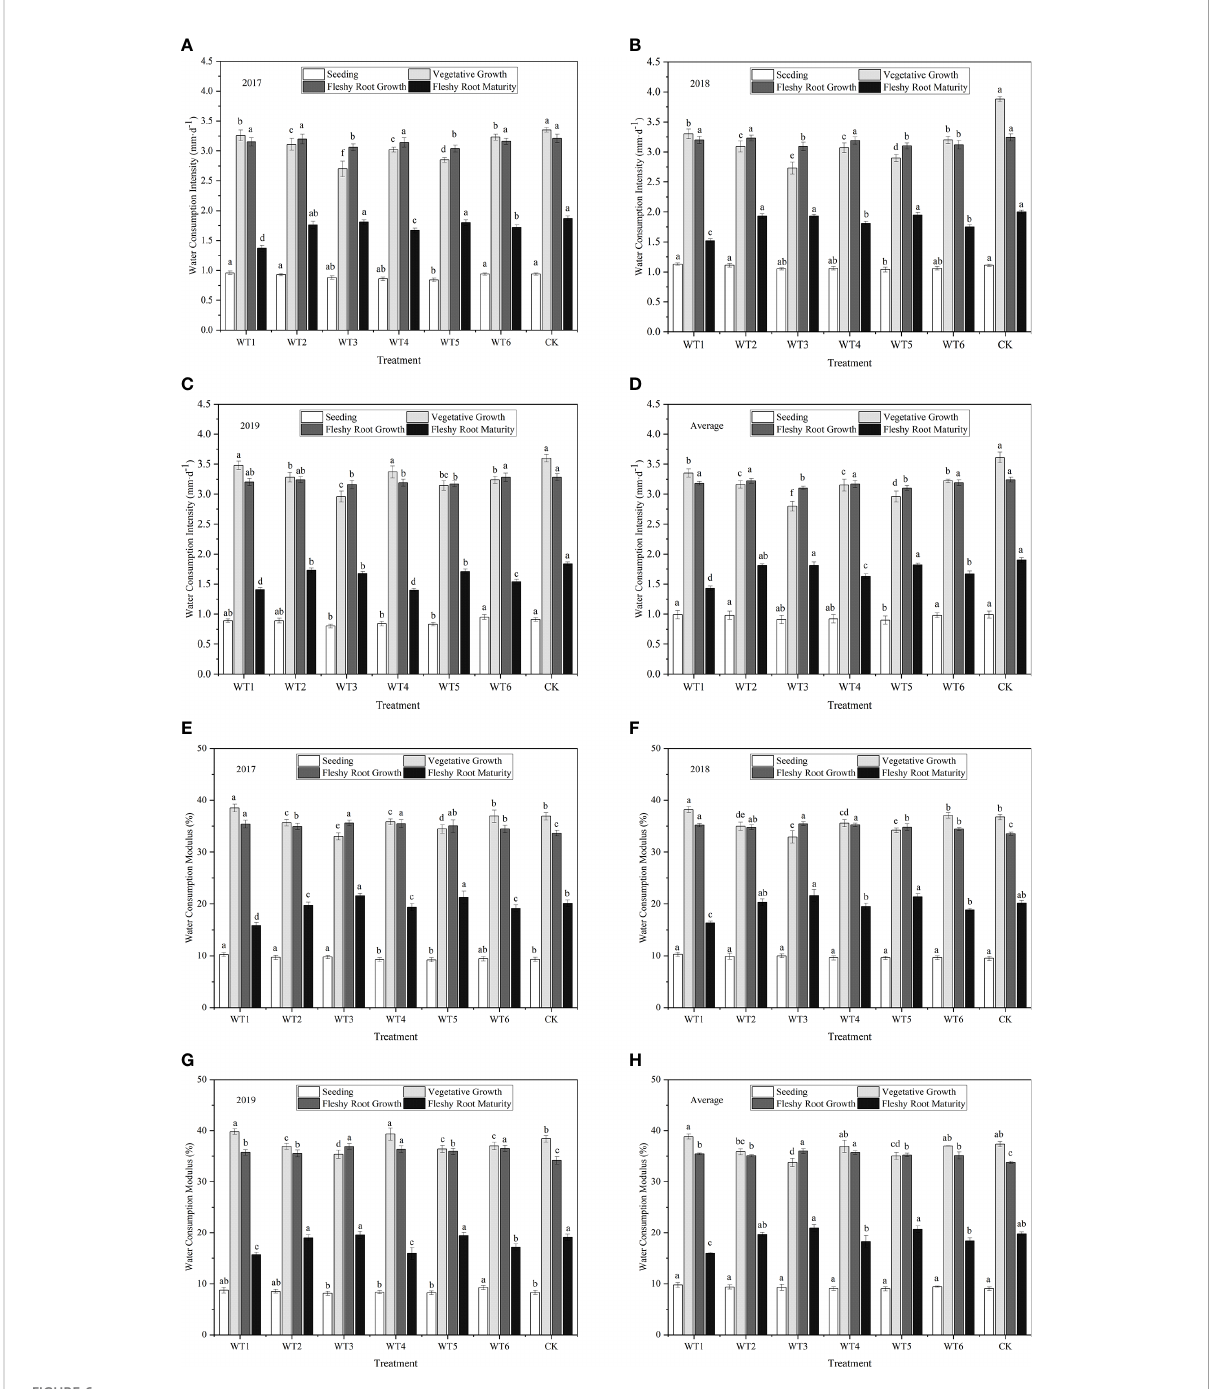
FIGURE 6 Water consumption intensity and water consumption modulus of I. indigotica plants in different water de fi cit treatments. (A – D) describe the water consumption intensity in 2017, 2018, 2019, and the average of these three years, respectively, while (E – H) describe the water consumption modulus in 2017, 2018, 2019, and the average of these three years, respectively. Different lowercase letters in the same column indicate signi fi cant differences ( P < 0.05). Data were presented as mean ± SE (n =